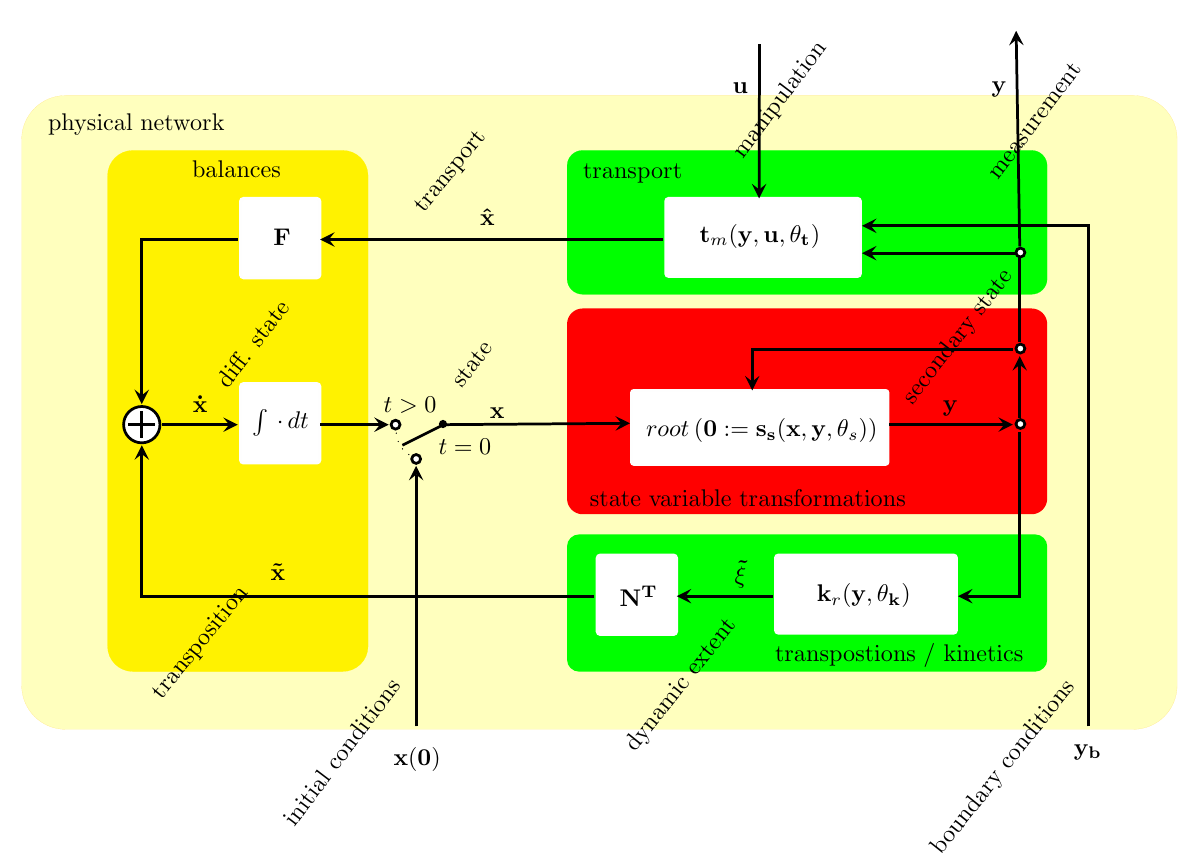
Figure 2. A generic dynamic physical